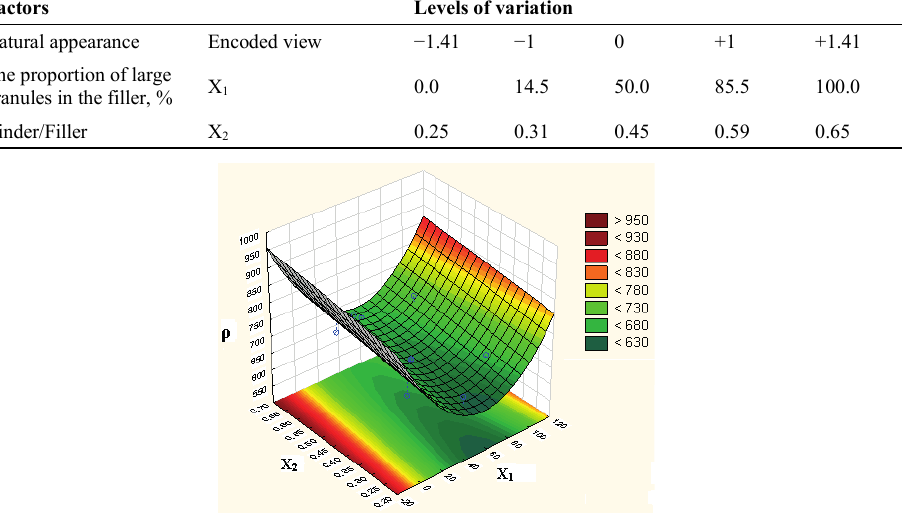
Fig. 5. The response surface of the dependence of the density of magnesia composites on the composition of the moulding